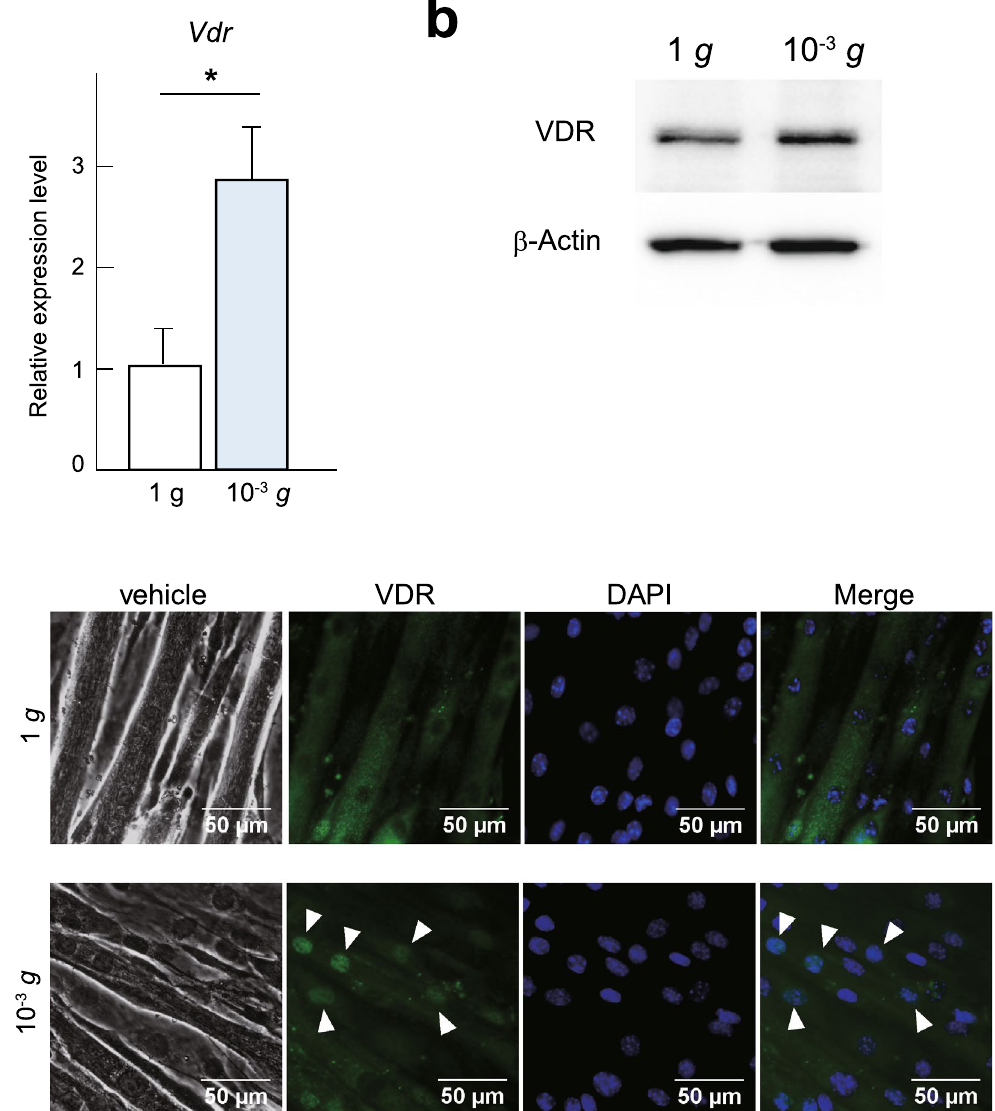
Figure 2. VDR is induced in response to simulated microgravity. ( a ) Vdr mRNA expression in C2C12 myotubes cultured for 48 h at 1 g or under simulated microgravity (10 −3 g ). Data are means ± s.d. n = 5. Mann– Whitney test. * P < 0.05. ( b ) Western blot of VDR and β-Actin in C2C12 myotubes cultured for 48 h at 1 g or under simulated microgravity (10 −3 g ). Representative images of at least 3 independent experiments are shown. ( c ) Phase contrast images and immunocytochemical staining for VDR (green) in C2C12 myotubes cultured for 48 h at 1 g or under microgravity (10 −3 g ). Nuclei were counterstained with DAPI (blue). Scale bars, 50